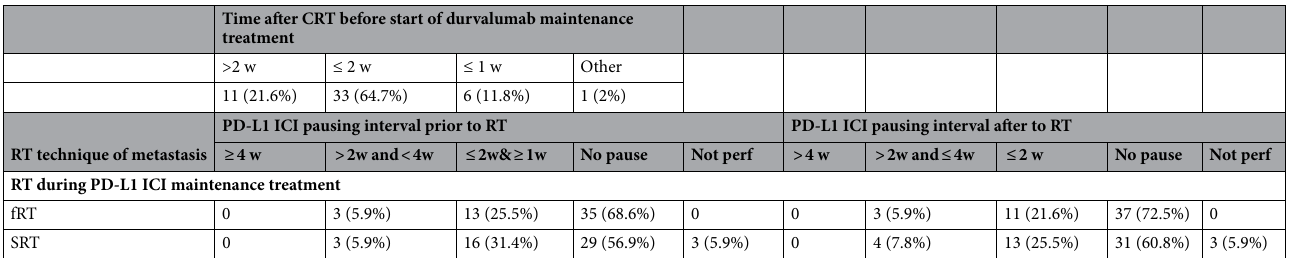
Table 4. Practical handling of durvalumab maintenance therapy after chemoradiotherapy (CRT) for non small cell lung cancer (NSCLC) and pausing times prior and after radiotherapy (RT) of metastases during maintenance therapy with programmed cell death-ligand 1 (PD-L1). Data is provided in absolute numbers of answers and in percentage of the total number of participants (N = 51). “Not perf.” indicates that this type of therapy is not performed. “w” stands for weeks. nfRT normofractionated radiotherapy, SRT stereotactic